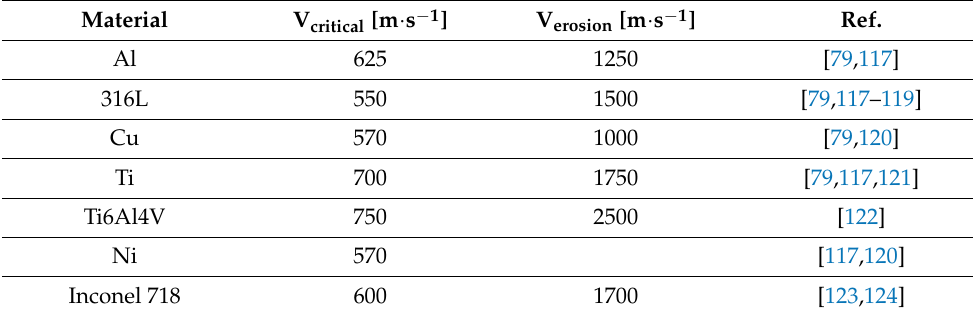
Table 1 lists the V cr and V er for the most CSAM-ed materials. Table 1. Window of deposition for